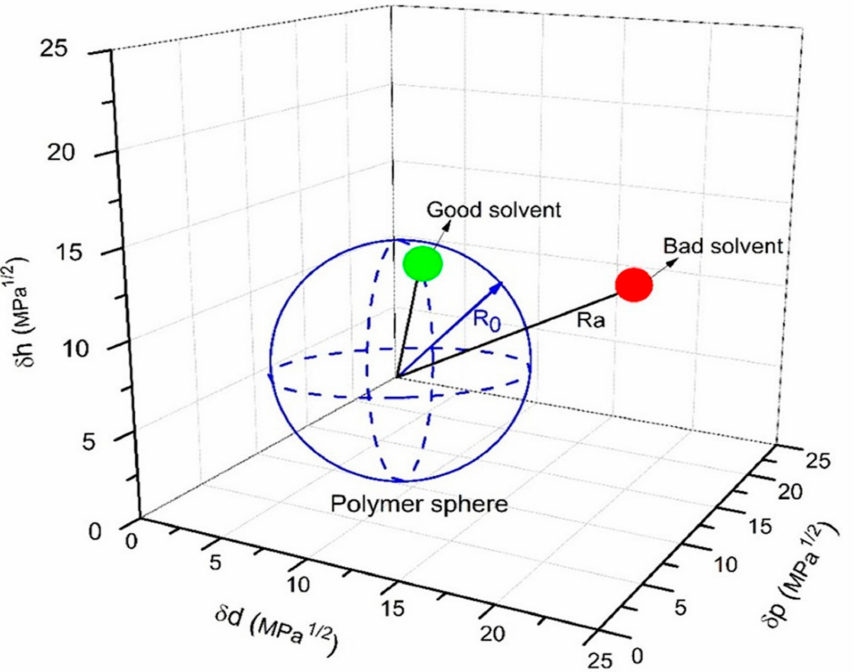
Figure 2. Interaction radius of the Hansen solubility sphere (R 0 ) for the radius determination of the good and bad solvents